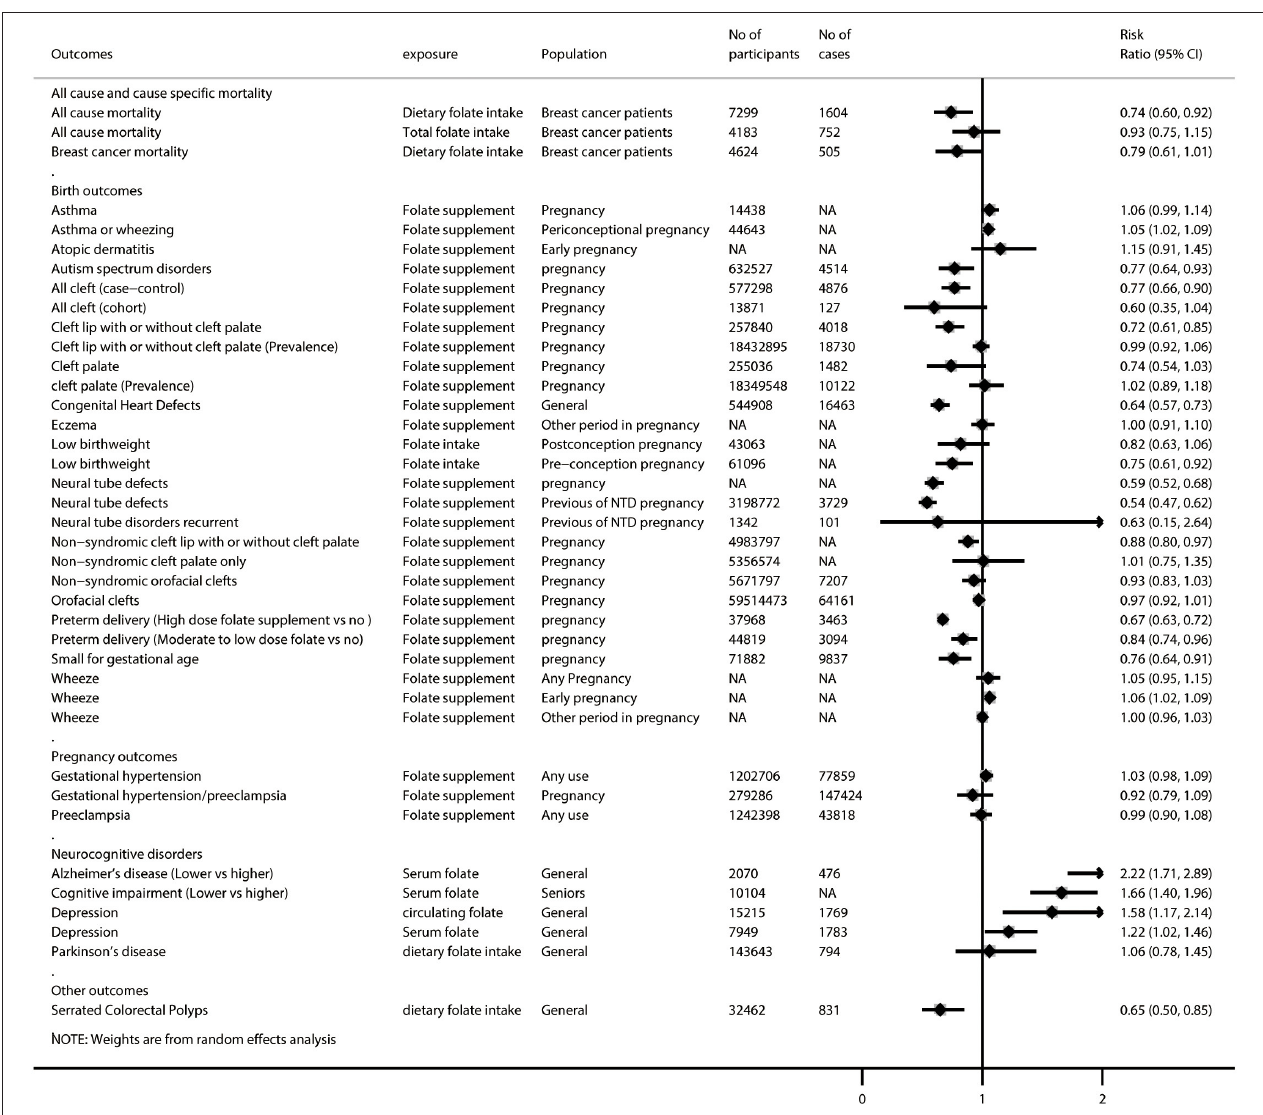
FIGURE 2 | Summary random-effects estimates of cancer outcomes and cardiovascular outcomes reported in meta-analyses of observational studies.